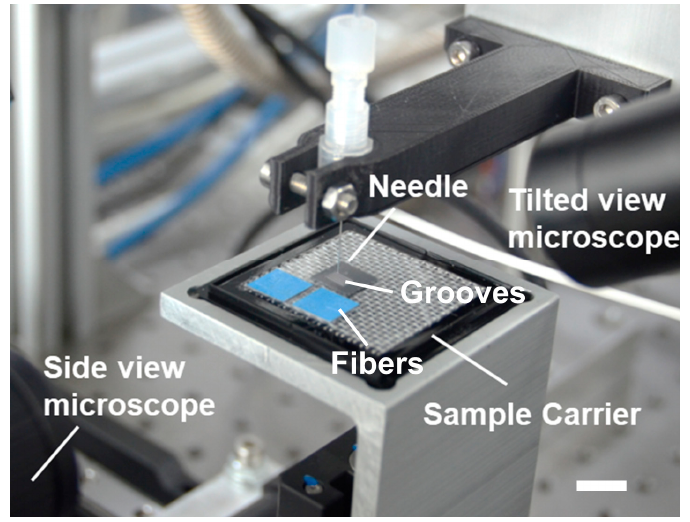
Figure 3. Robotic system for surface tension-based alignment of microfibers on hydrophilic–superhydrophobic grooves. Scale bar: 10 mm.